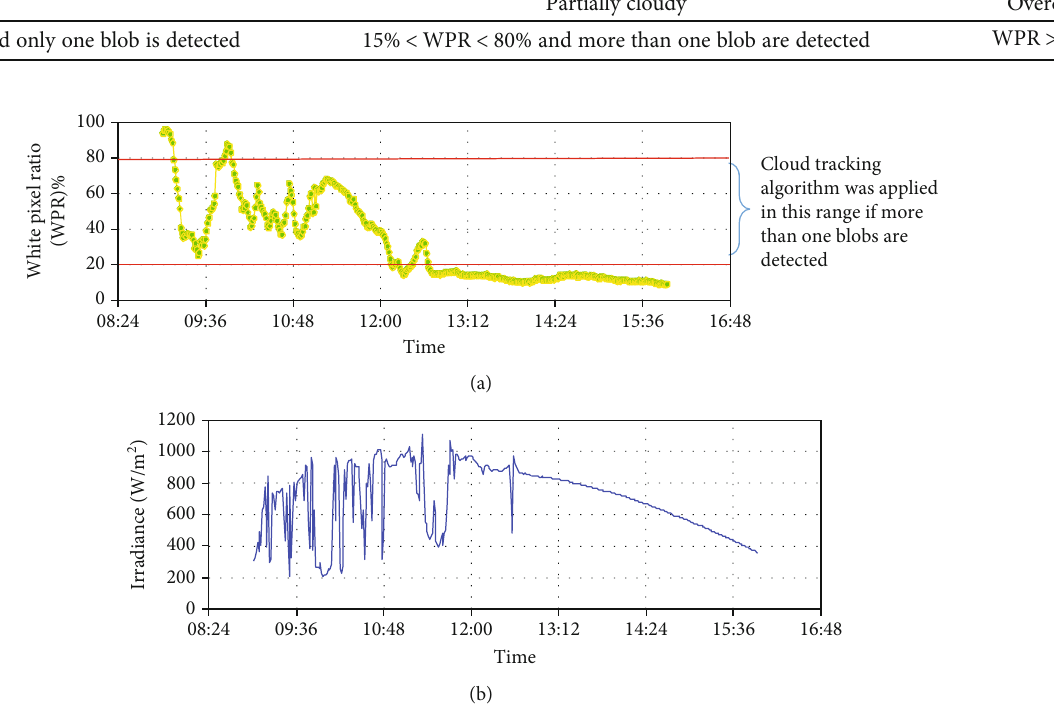
Table 2: Sky categorization. Sunny Partially cloudy Overcast WPR < 15 % and only one blob is detected